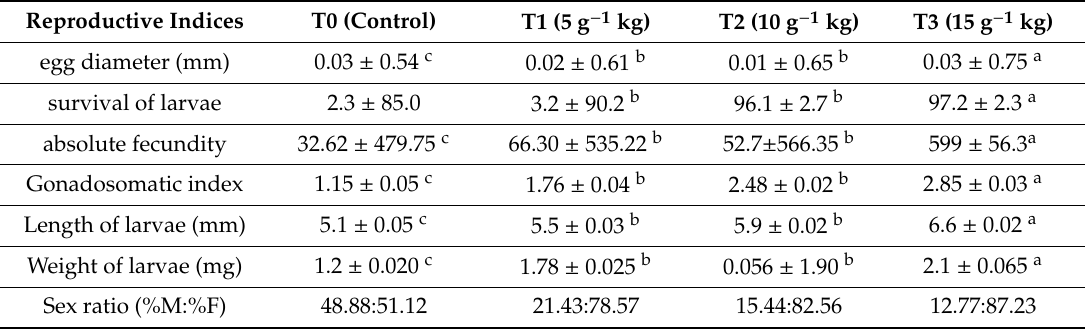
Table 4. Reproductive e ff ects of Vitex agnus-castus extract on broodstock of zebrafish. Reproductive